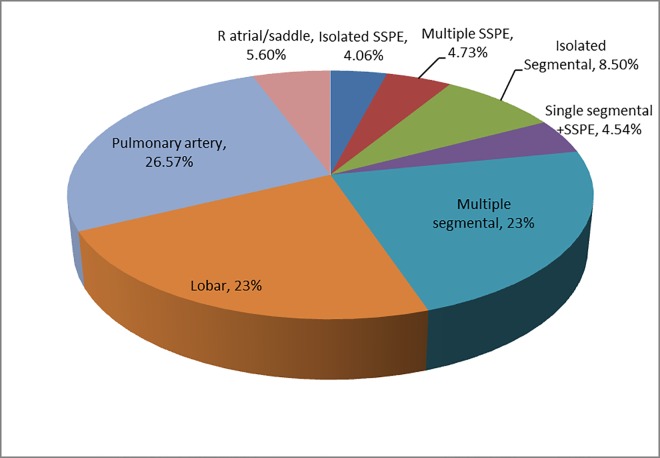
Rates of PE at different levels in total population of positive PE on CTPA (%).